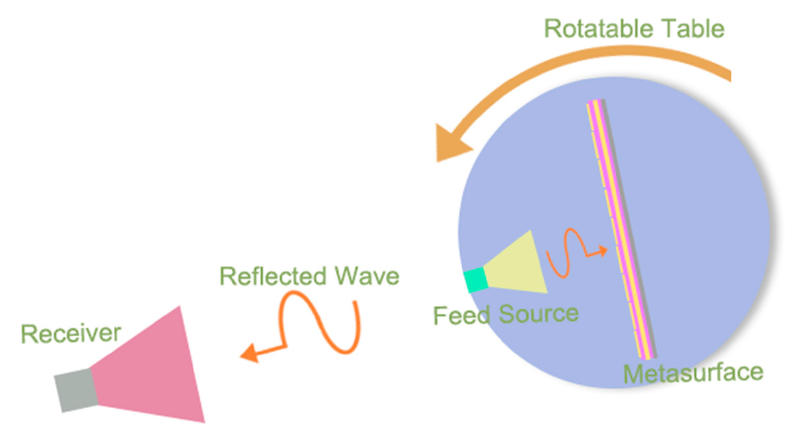
Figure 5. The experimental environment of the far-field test.